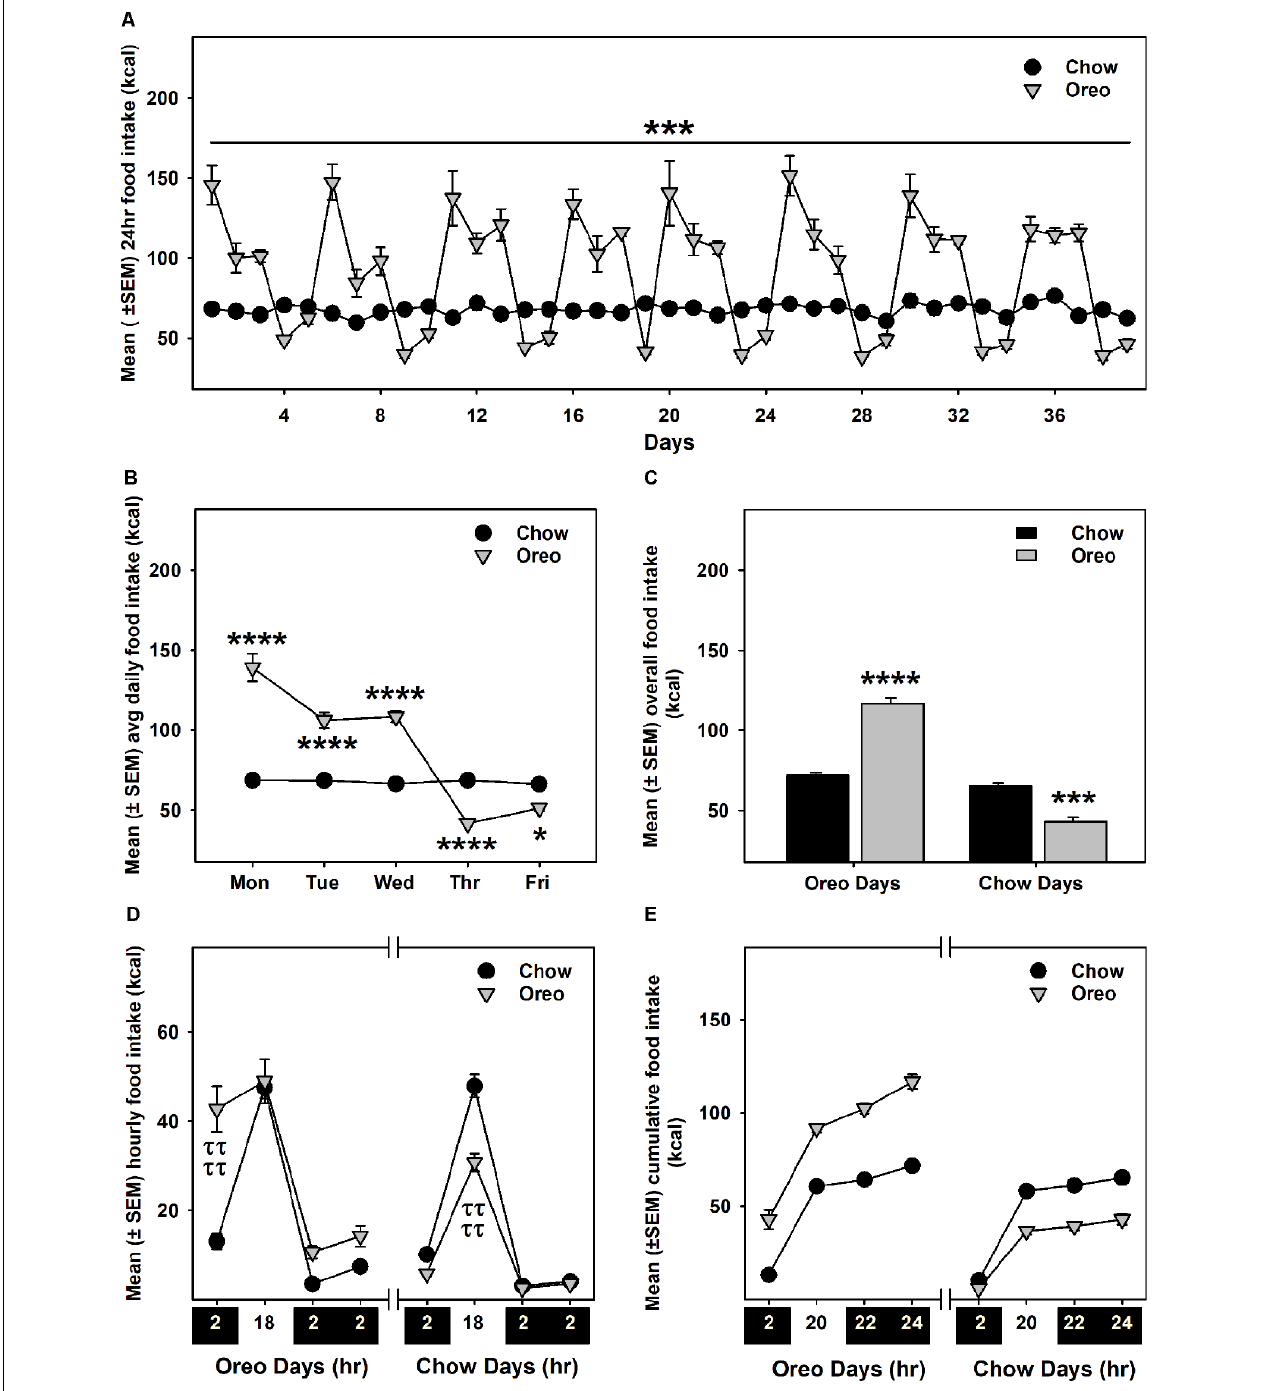
FIGURE 2 | Energy intake during the 8-weeks of patterned HPF feeding. Data compare mean ( ± SEM) 24 h food intake (kcal) between chow and HPF group. (A) Rats in the HPF group followed a pattern where they significantly overconsumed on HPF access days (i.e., Mon, Tue, and Wed) and under-consumed on chow-only access days. *** p < 0.001 main effect of diet exposure. HPF group of rats significantly overconsumed and under-consumed on Oreo-access days and chow-access days respectively when data were compared as indicated by the average of daily food intake (B) and overall food intake during the exposure period (C) . * p < 0.05, *** p < 0.001, **** p < 0.0001 compared to chow controls. Food intake (kcal) was also measured at different timepoints after initiation and suspension of HPF respectively. Data represents ( ± SEM) hourly (D) and cumulative (E) food intake at these time-points. HPF rats significantly overconsumed during the first 2 h (0–2 h) on the Oreo days, and significantly under-consumed during the 2–18 h timeframe on Chow days. ττττ p < 0.0001 compared to chow controls. *** p < 0.001, **** p < 0.0001 main effect of diet exposure. HPF, hyper-palatable food.